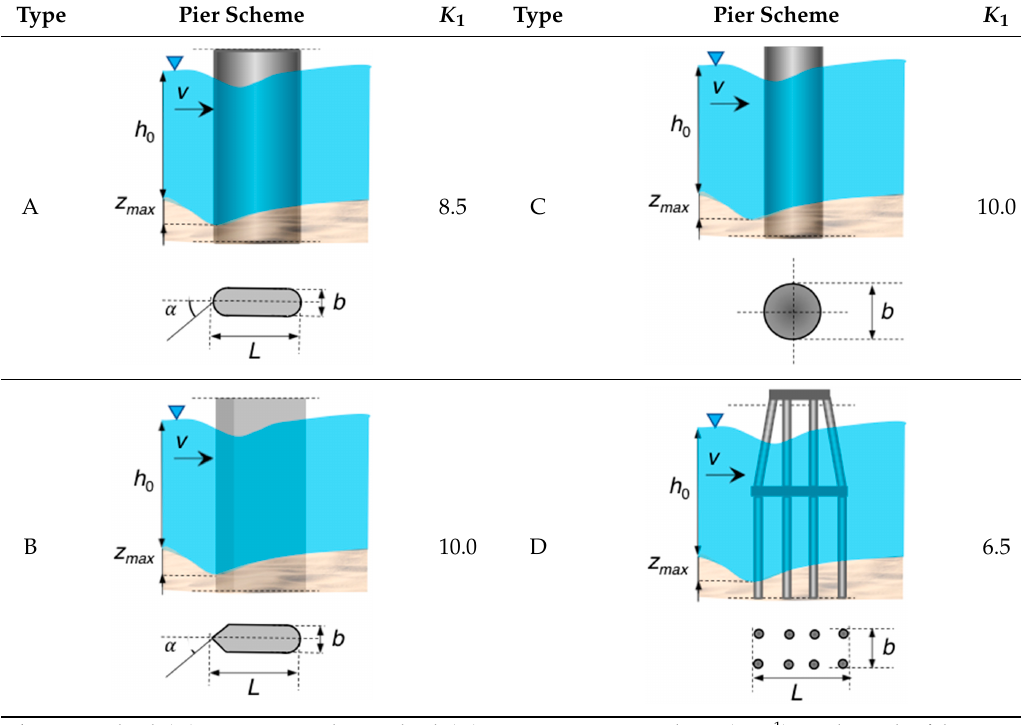
Table 3. Chosen pier construction types and K 1 parameter value (in accordance with Journal of Laws [11]).